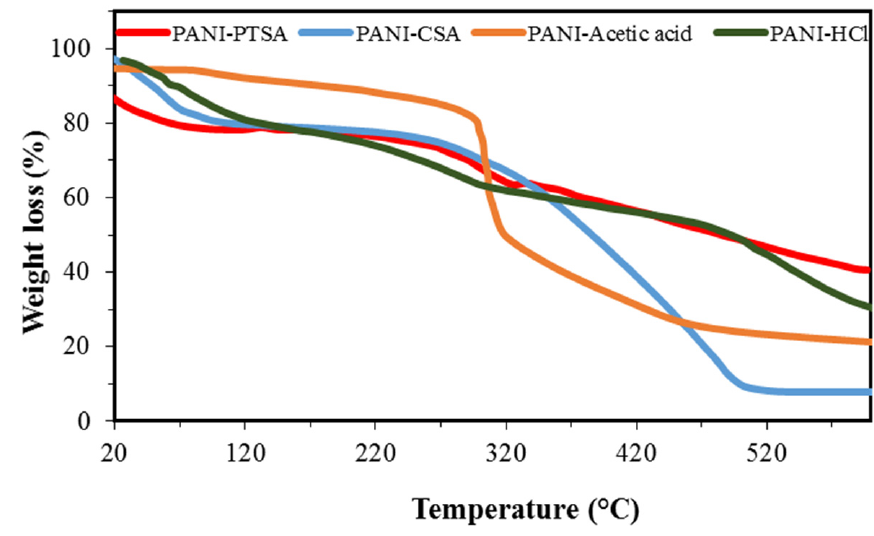
Figure 7. TGA spectra of synthesized PANI samples.